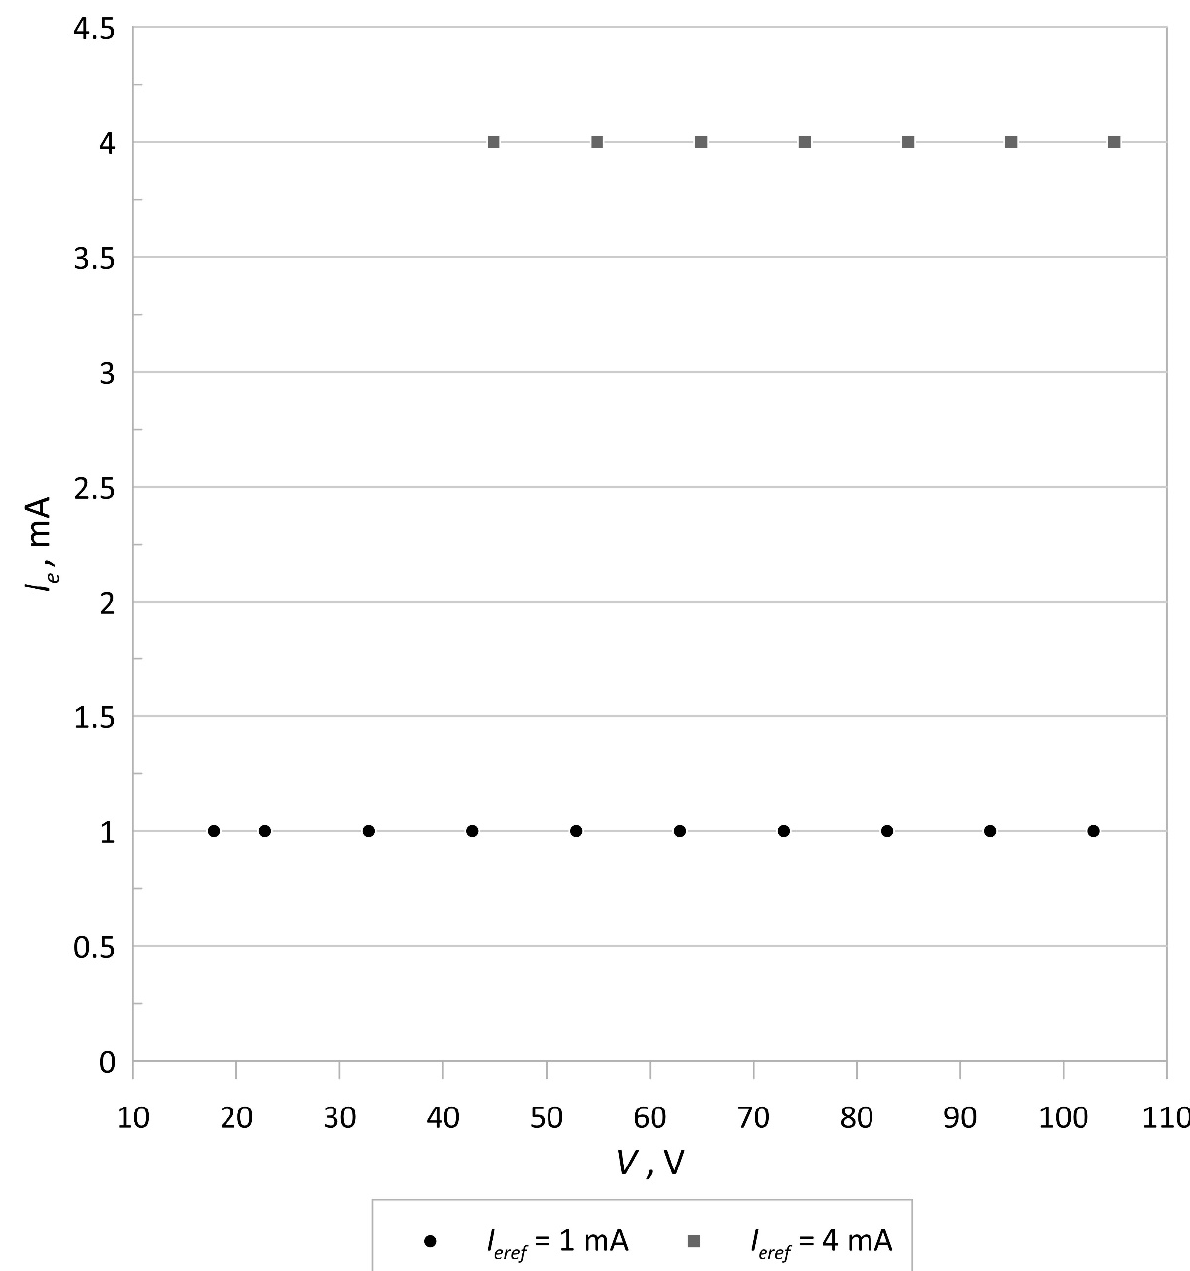
Figure 5. Plot of the emission current I e versus the electron accelerating voltage V . To show the stability of the emission current, its standard deviation was deter- mined. The duration of the measurement for each value of the emission current was 180 s, which is longer than the usual measurement time for mass spectrometer isotope ratios. Figures 6 and 7 show plots of the standard deviation and percentage standard deviation of the emission current,